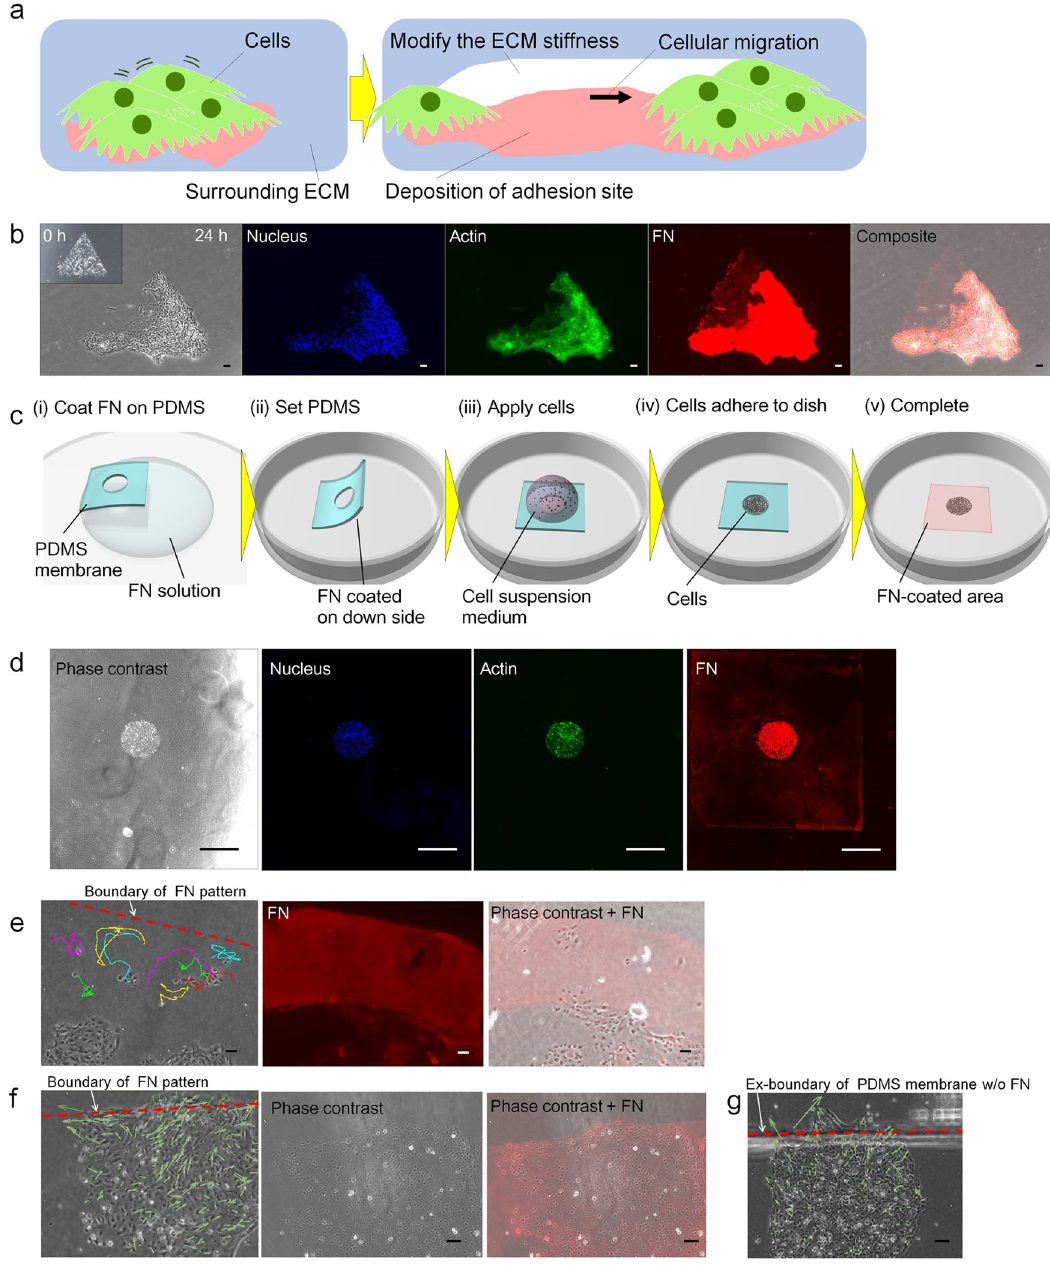
Fig. 1 Deposition of FN regulates the cellular migration area. a Schematic representation of microenvironment remodelling. During collective cell migration, ECM is continuously degraded and constructed. b Immunostaining results of the nucleus, actin and FN. NHBE cells were initially placed in a triangular shape, and were observed to have migrated towards the lower right corner after 24 hours, although FN remained in the area without cells. c Schematics of the procedure for simultaneous dual patterning of cells and FN. d Phase contrast and immunostaining of the nucleus (DAPI), actin and FN show the dual patterning of NHBE cells and FN. A rectangular FN boundary was patterned on a dish, and NHBE cells then patterned in the centre of the FN area. e Tracking of cell migration inside the FN-patterned area. The red dotted line indicates the FN boundary, which was determined from the staining results. f Cellular behaviour in the crowded area near the FN boundary. Immunostaining of FN is shown in red. g Control experiment without FN patterning. The complete time-lapse movies for parts e – g are shown in Supplementary Movies 1 – 3. Scale bar: 100 μ m ( b , e – g ) and 1 mm ( d